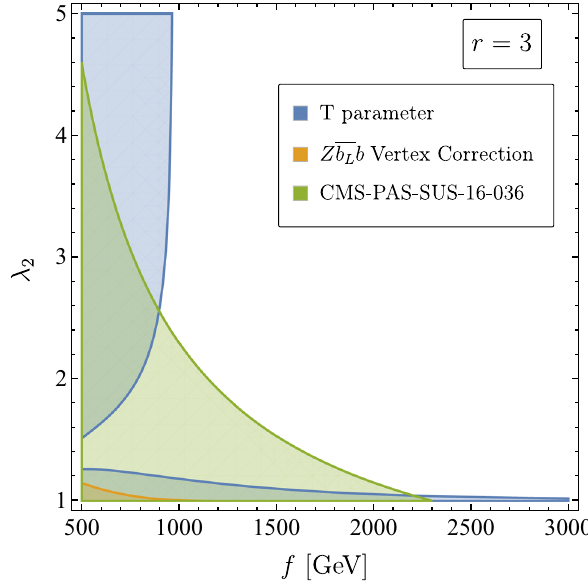
Fig. 4 Combined EWPT and LHC exclusion regions in the ( f ,λ 2 ) plane, for r = 3 and (cid:23) = 4 π f . The EWPT exclusion regions due ¯ bb (orange region) are plotted at to T-parameter (blue region) and δ g Z L the 3 σ level using the results of Ref. [45], T = 0 . 12 ± 0 . 07 and = 0 . 002 ± 0 . 001. The LHC exclusion (green region) is due to δ g b ¯ b L Ref. [42] using the lower bound of Eq.